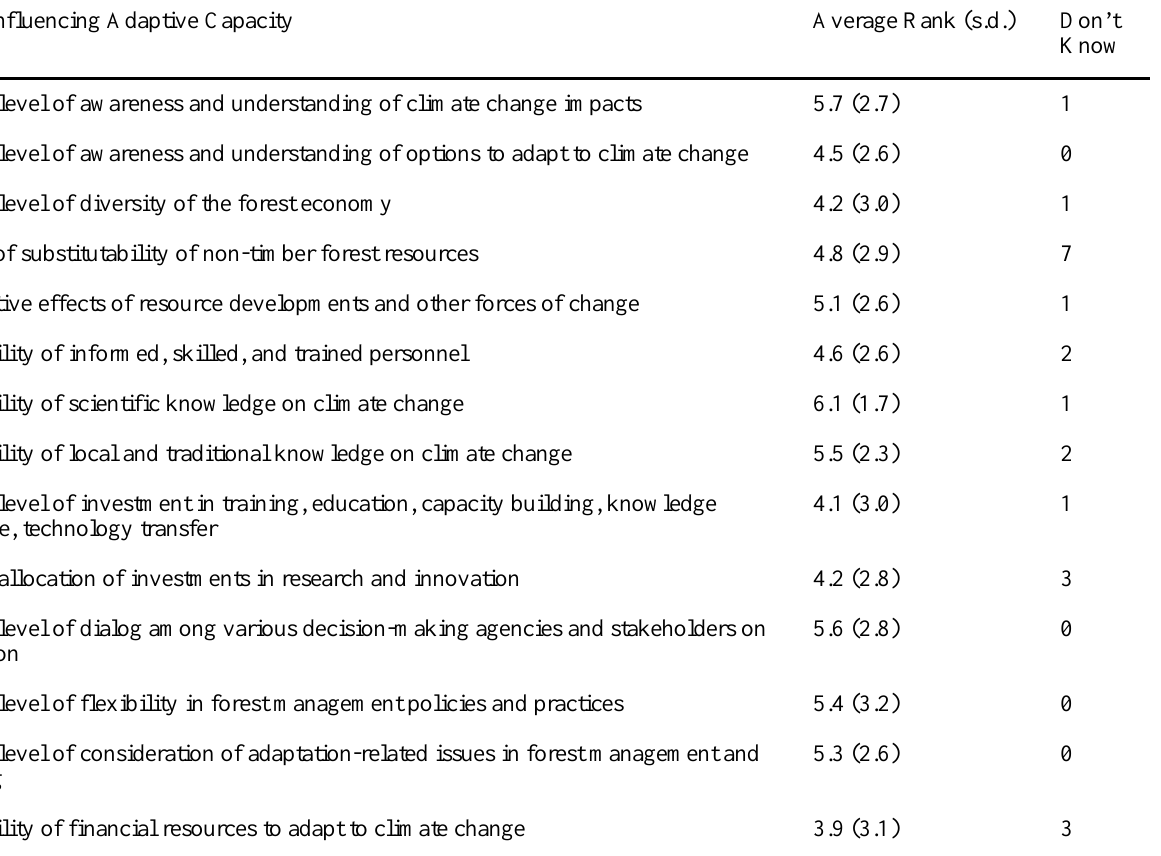
Table 2. Judgments of forest practitioners on the degree to which various factors that contribute to enhancing the adaptive capacity of the forest sector and forest-based communities to climate change are present in the Champagne and Aishihik Traditional Territory. Results provide an indication of whether the factor is high or low in the region. Scale of 1 to 10 (0 = no contribution, 1 = low contribution, 10 = high contribution) or don’t know. Results shown are the average rank and standard deviation (s.d.) of participants who provided a ranking and number of participants who indicated that they don’’t